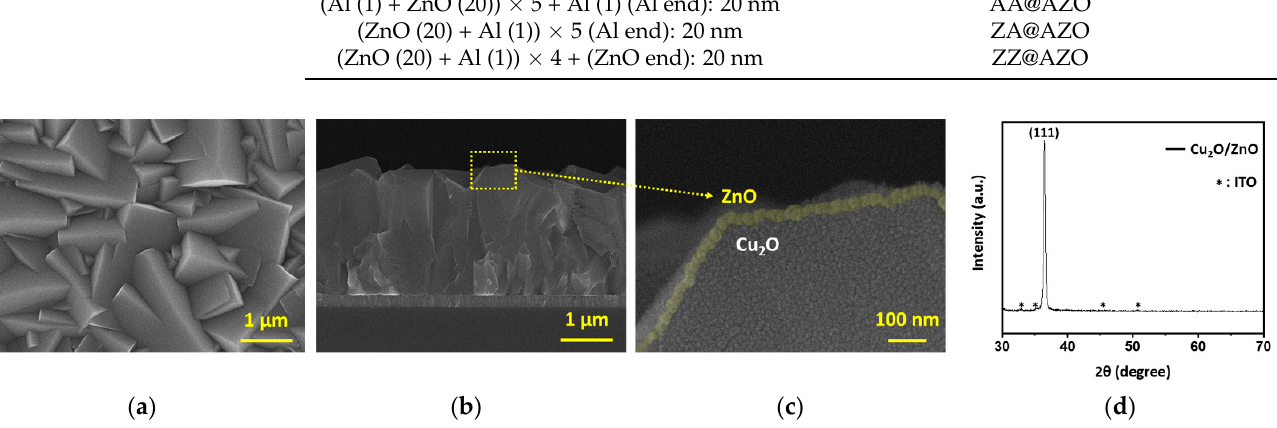
Figure 1. ( a ) Top view, ( b , c ) cross-view SEM images, and ( d ) X-ray diffraction pattern of the ZnO-overlayered Cu 2 O film.